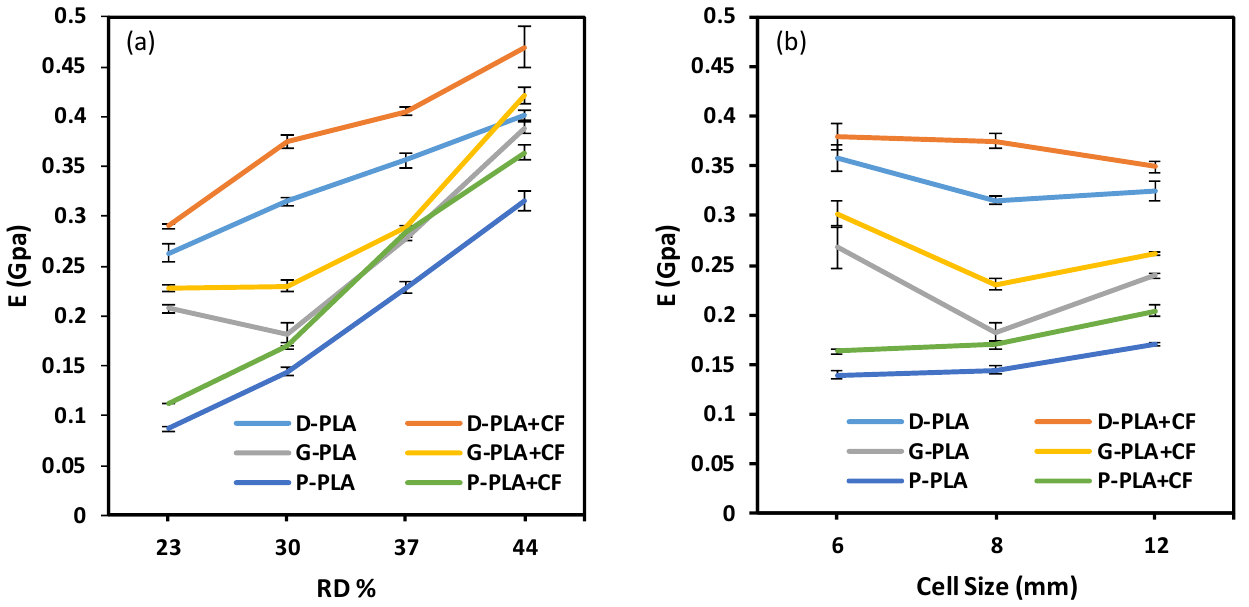
Figure 10. Compressive modulus of the Diamond, Gyroid, and Primitive structures at ( a ) different RDs while cell size remained at 8 mm and ( b ) different cell sizes while RD% remained at 30%. It is worth mentioning that the TPMS topology type (Diamond, Gyroid, and Primitive) substantially affects the compressive modulus and strength. This demonstrates that the mechanical properties of lattice structures are sensitive not only to the RD and material composition but also to the design type (P, G, and D) and unit cell